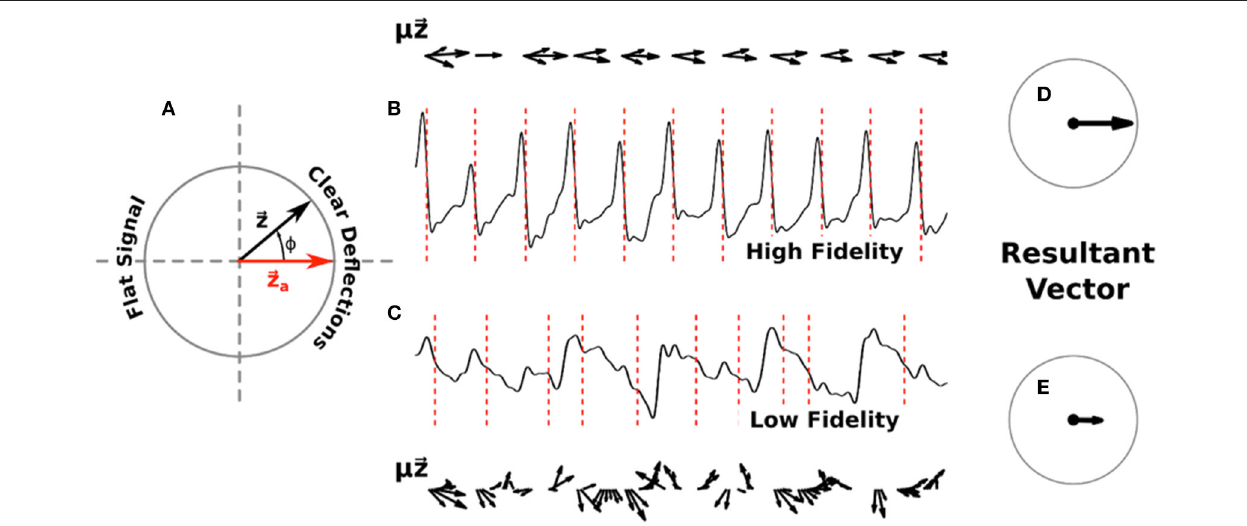
⇀ z a represents activation, with the FIGURE 1 | Diagram of signal fidelity computation. (A) A visual representation of phase in the complex plane. The red vector ⇀ z rotating counter-clockwise around the unit circle as determined by the computed phase of a given signal. (B) A sample filtered electrogram complex phase vector ⇀ z ( t ), scaled by the deflection with high signal fidelity, exhibiting clear deflections which are well-marked by the computed activations (red dotted lines). Phase vectors amplitude µ ( t ), are shown above this trace in 10ms increments. (C) A sample filtered electrogram with low signal fidelity, exhibiting ambiguous deflections. Phase ⇀ z ( t ), scaled by the deflection amplitude µ ( t ), are shown below this trace in 10ms increments. For clarity, vectors with magnitude below a minimum threshold vectors are not shown. Panels (D) and (E) show the normalized vectors resulting from the sum of scaled phase vectors for each respective trace across 20s of data. Signal ⇀ z a fidelity is computed as the dot product of this resultant vector and